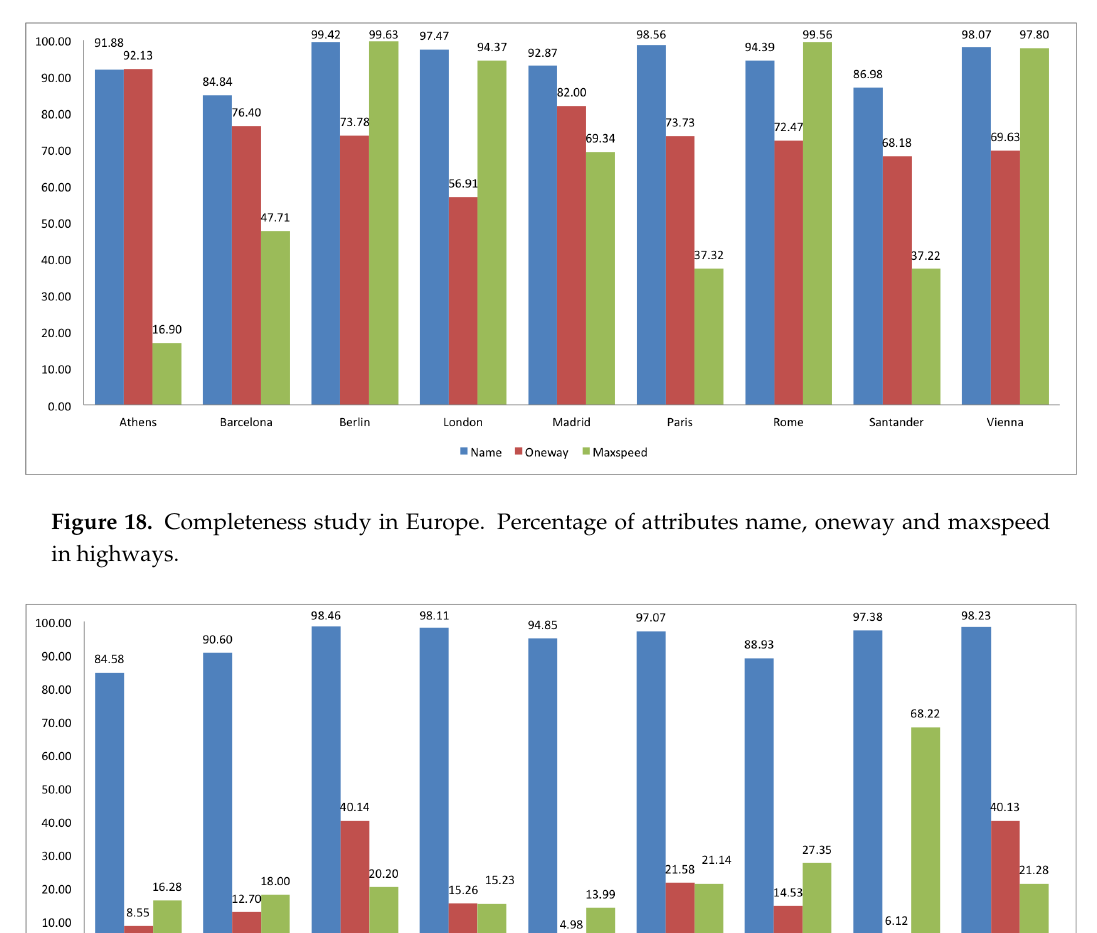
Figure 17. Completeness study in Europe. Proportion of house numbers and buildings.